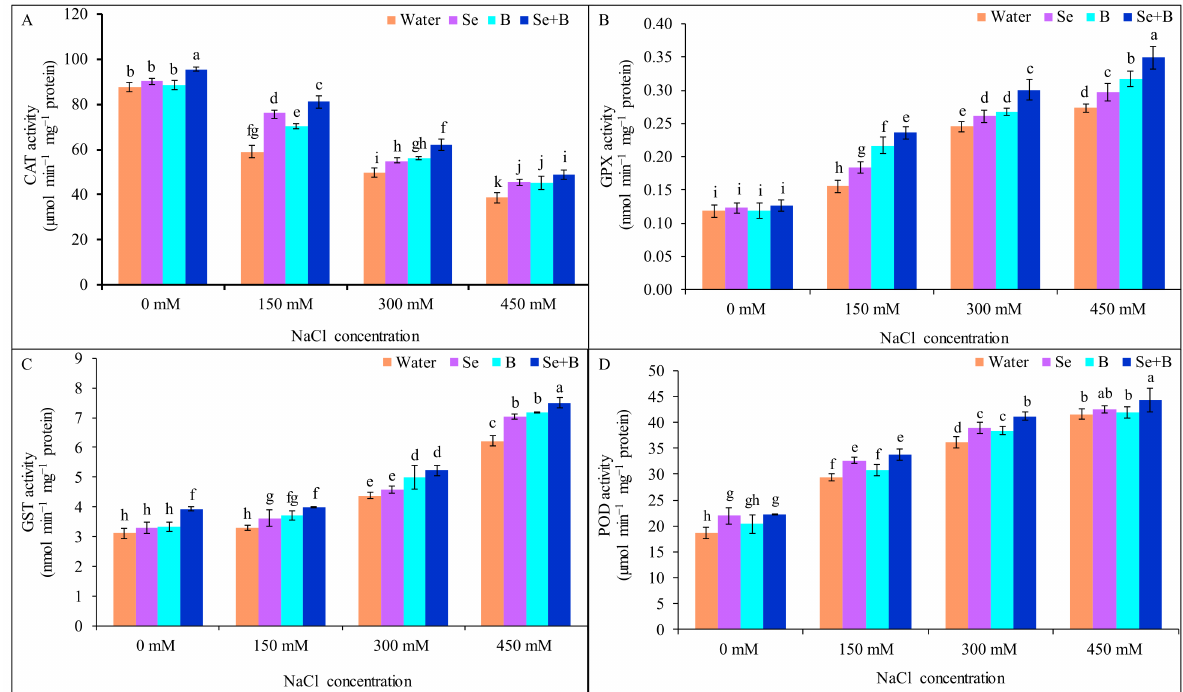
Figure 4. Effect of exogenous Se, B and Se+B on CAT activity ( A ), GPX activity ( B ), GST activity ( C ) and POD activity ( D ) in soybean at 0, 150, 300 and 450 mM NaCl-induced salt stress. Here, Se, B and Se+B indicate 50 µ M Na 2 SeO 4 , 1 mM H 3 BO 3 and 50 µ M Na 2 SeO 4 + 1 mM H 3 BO 3 , respectively. Values in a column with different letters are significantly different at p ≤ 0.05 applying Fisher’s LSD